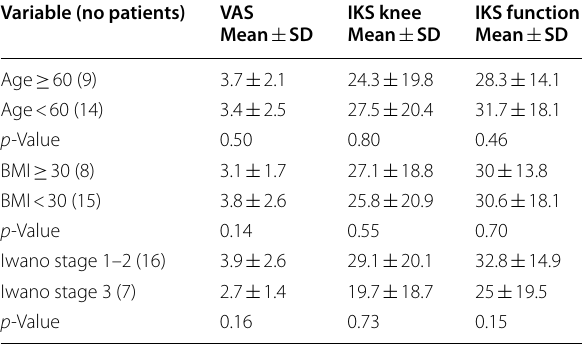
Table 4 Differences in improvements of IKS knee and function and VAS scores relative to the age and BMI of patients and stage of PFOA